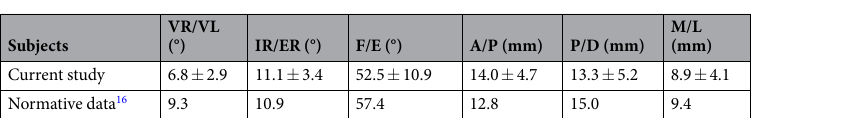
Table 3. The results of the patients’ knee ROMs in 6DOF during gait (mean ± standard deviation). F/E, flexion/ extension; IR/ER, internal/external femoral rotation; VR/VL, varus/valgus; A/P, anterior/posterior femoral translation; P/D, proximal/distal femoral translation ML, medial/lateral femoral